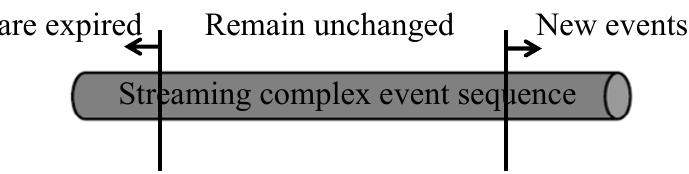
Figure 6. An example of events deletion and